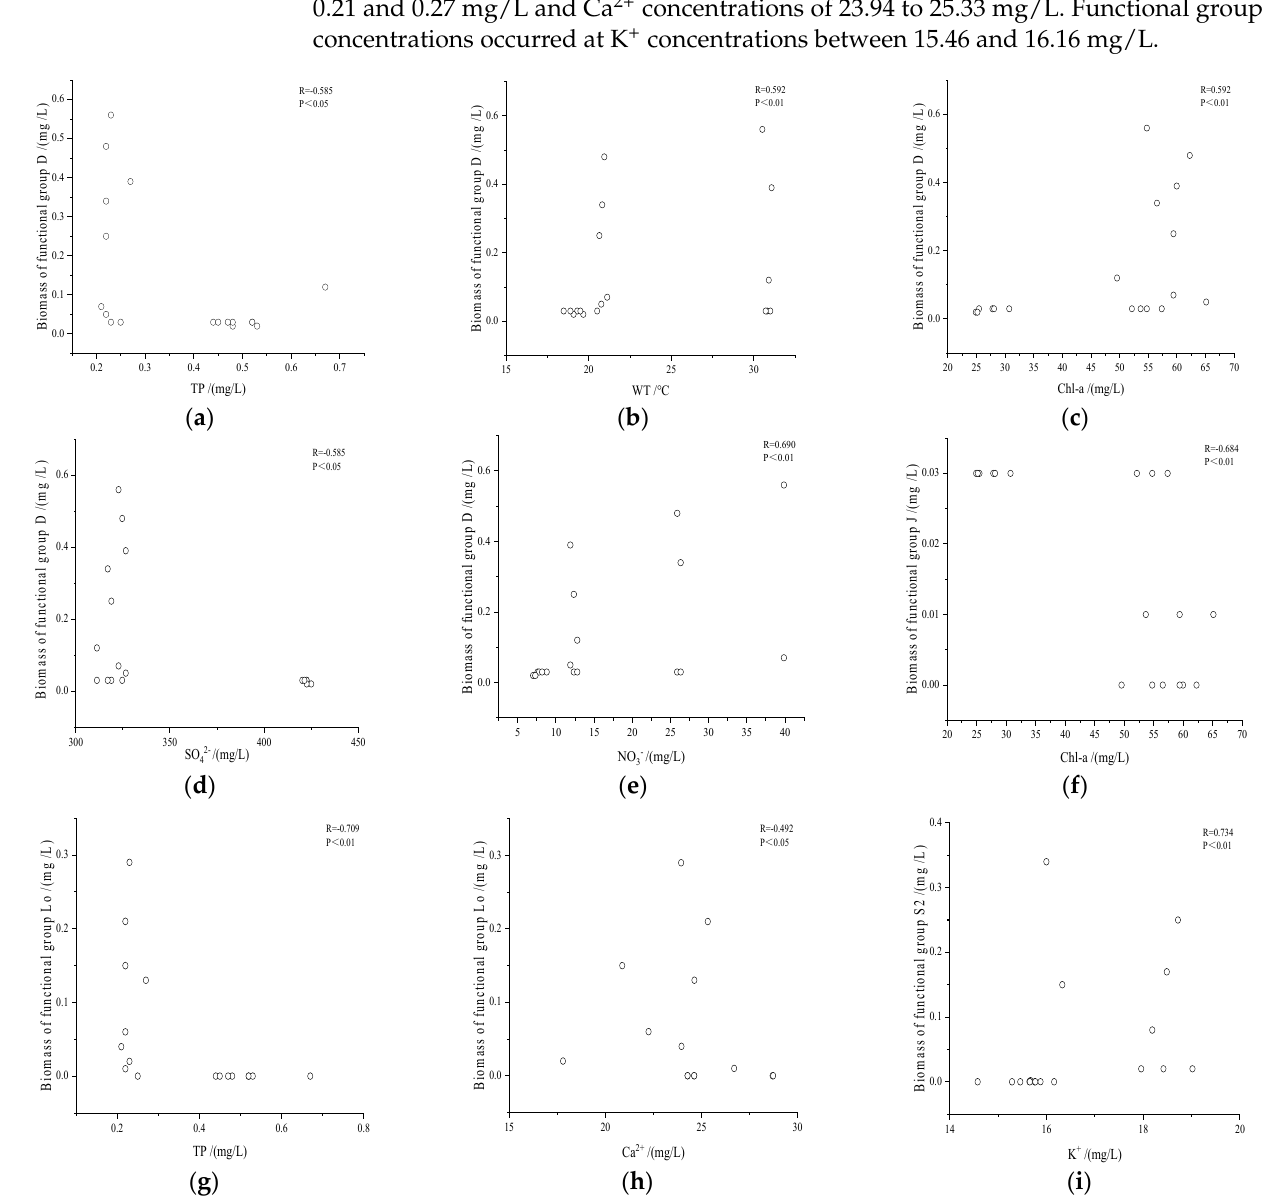
12 of 20 Figure 7. Pearson correlation analysis of environmental factors and Q index and TMIS index in Nanhai Lake. Notes: ** Indicates that the correlation is significant at the 0.01 level (double tails), * indicates that the correlation is significant at the 0.05 level (double tails) 3.3.2. Spearman Correlation Analysis of Dominant Functional Groups and Environmen- tal Factors Correlation analysis of the dominant functional group biomass and environmental factors in Nanhai Lake was conducted, and the results are displayed in Figure 8. Func- tional group D was correlated with a variety of environmental factors, which were signif- icantly negatively correlated with TP ( p < 0.05), very significantly positively correlated with WT and Chl − a ( p < 0.01), significantly negatively correlated with SO 42 − concentration